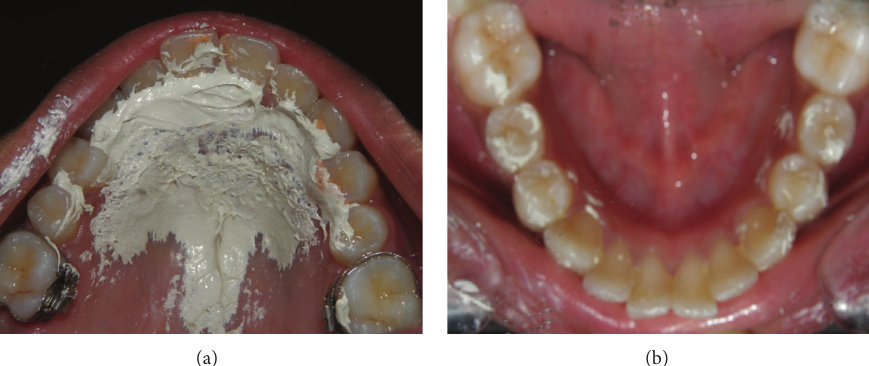
Figure 5: Palatographic analysis six months after the placement of HHCA showing impression material smeared over the maxillary rugae area missing the crown of the incisors indicating that the patient has attained a somatic swallow.